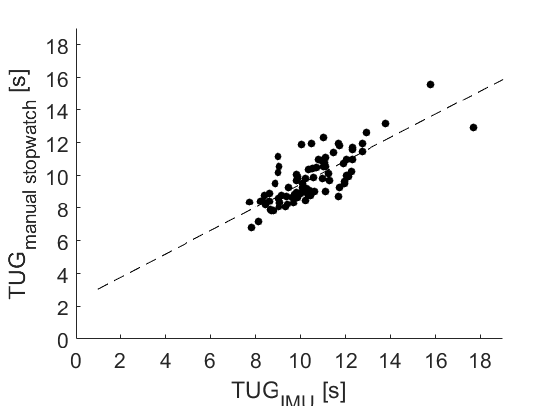
Figure 7. Linear regression among the manual stopwatch and the USS’s sensor belt measurements for the TUG test.